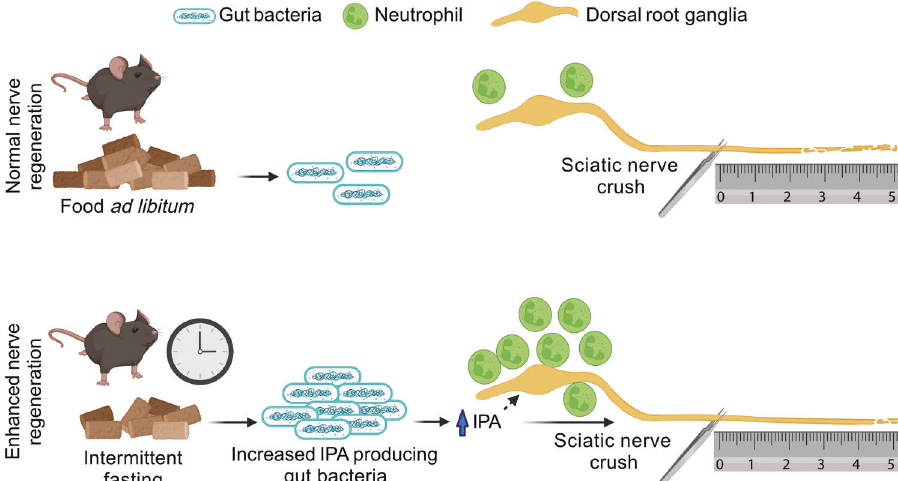
Fig. 1 Mice receiving food ad libitum (AL) or as an intermittent fasting (IF) diet were subjected to sciatic nerve crush injury. IF led to enhanced nerve regeneration compared to AL feeding. IF was also associated with elevated serum levels of indole-3-propionic acid (IPA) and IPA- producing gram-positive bacteria in the gut. The IF-induced enhanced nerve regeneration was recapitulated with fecal matter transplants from IF mice to AL mice, gut recolonization with Clostridium sporogenes , an IPA-producing bacteria, and systemic IPA delivery. Systemic IPA delivery induced dorsal root ganglia neutrophil in fi ltration, which was required for IPA enhancement of nerve regeneration. The fi gure was created with